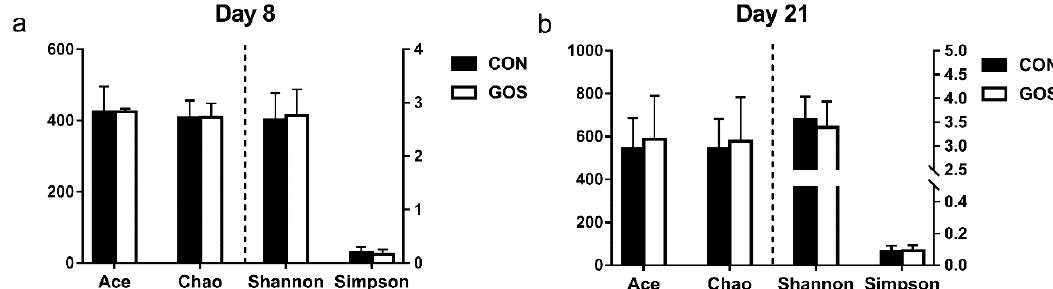
Figure 1. Effects of early-life galacto-oligosaccharides (GOS) intervention on the diversity of ileal microbiota at the 3% dissimilarity level of suckling piglets. ( a ) The diversity of ileal microbiota on day 8; ( b ) the diversity of ileal microbiota on day 21. Values are expressed as means ± SEM, CON, a control group; GOS, a galacto-oligosaccharides intervention group.